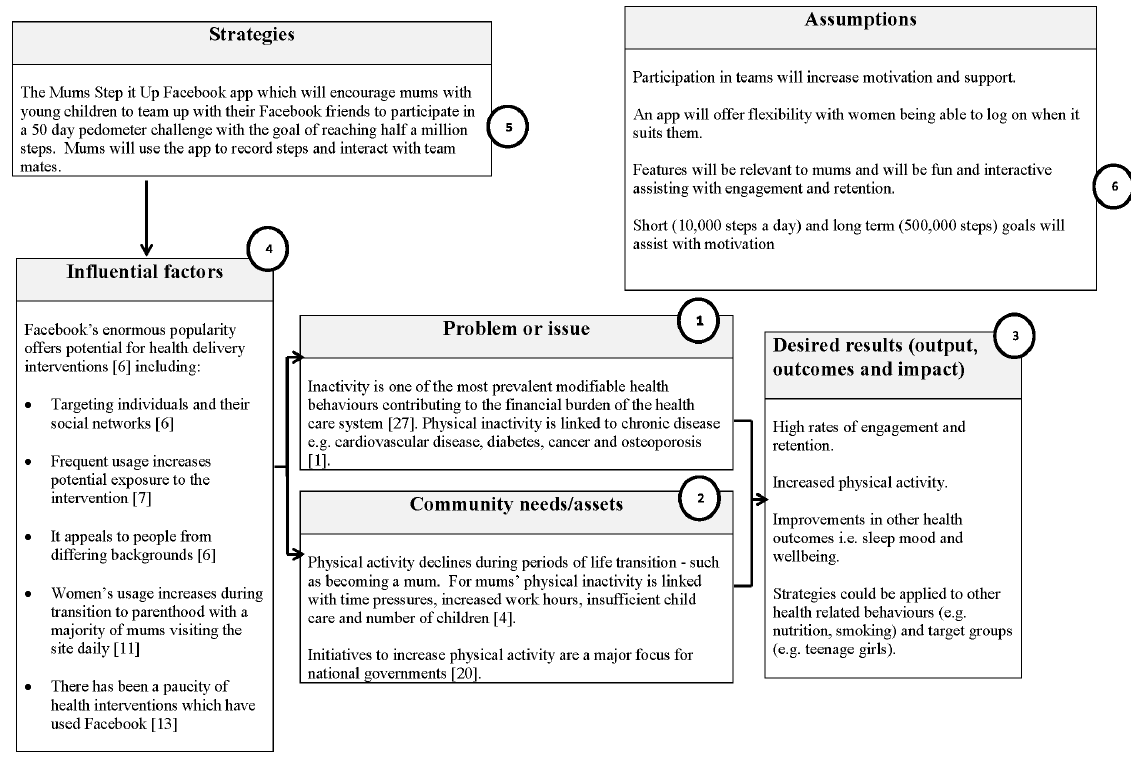
Figure 1. Flow chart of the Mums Step It Up program theory.